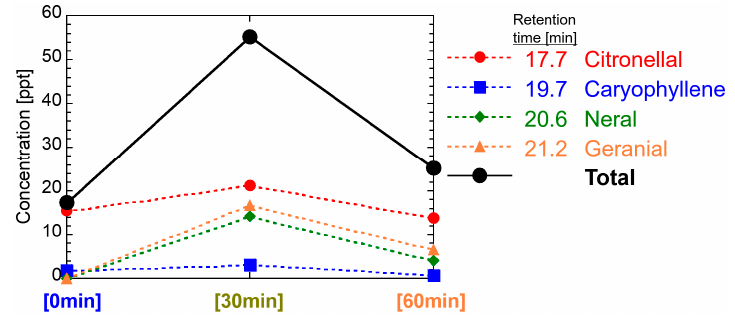
Figure 10. Temporal change of VOCs in the room air diffused by Melissa oil.